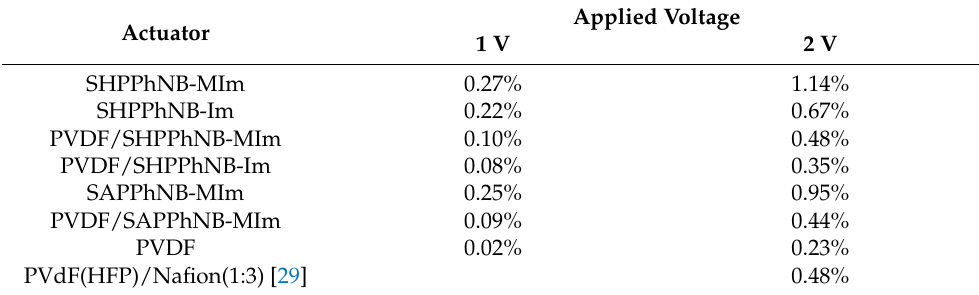
Table 5. Maximum generated strain calculated from tip displacement under different direct voltage.